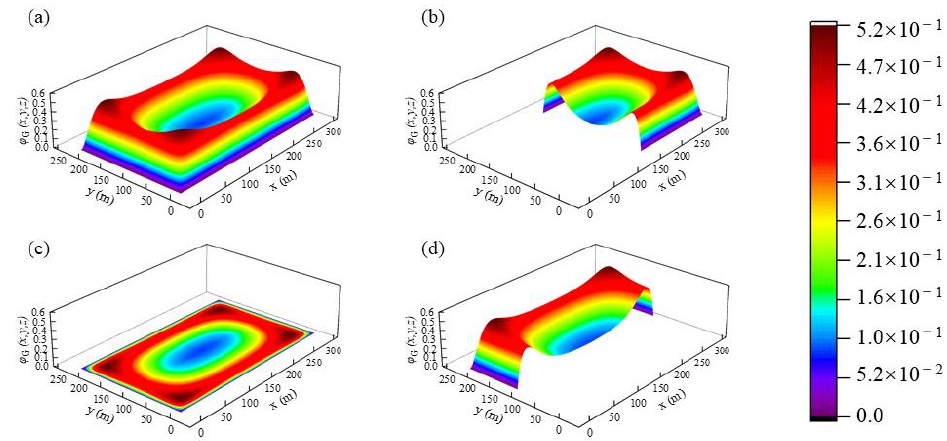
Figure 3. Distribution of porosity in the fracture zone of ( a ) global, ( b ) inclination, ( c ) plan, and ( d ) strike.